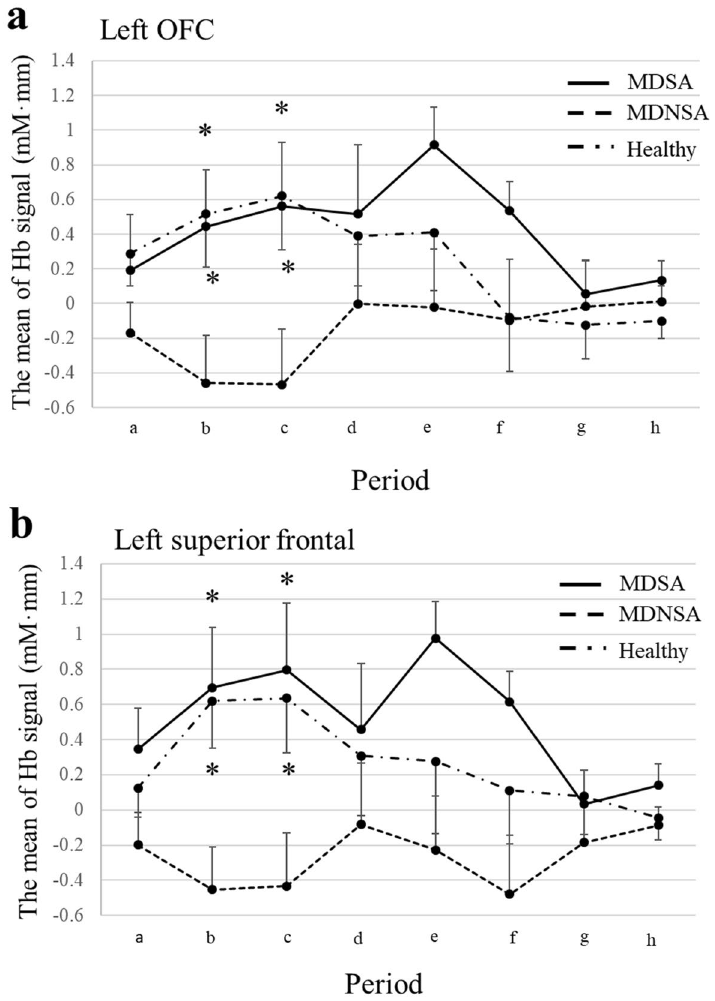
left OFC. *p < 0.05. ( b ) Significant differences between the MDSA and MDNSA groups, and between healthy participants and the MDNSA groups in periods b and c in left superior frontal area. *p <